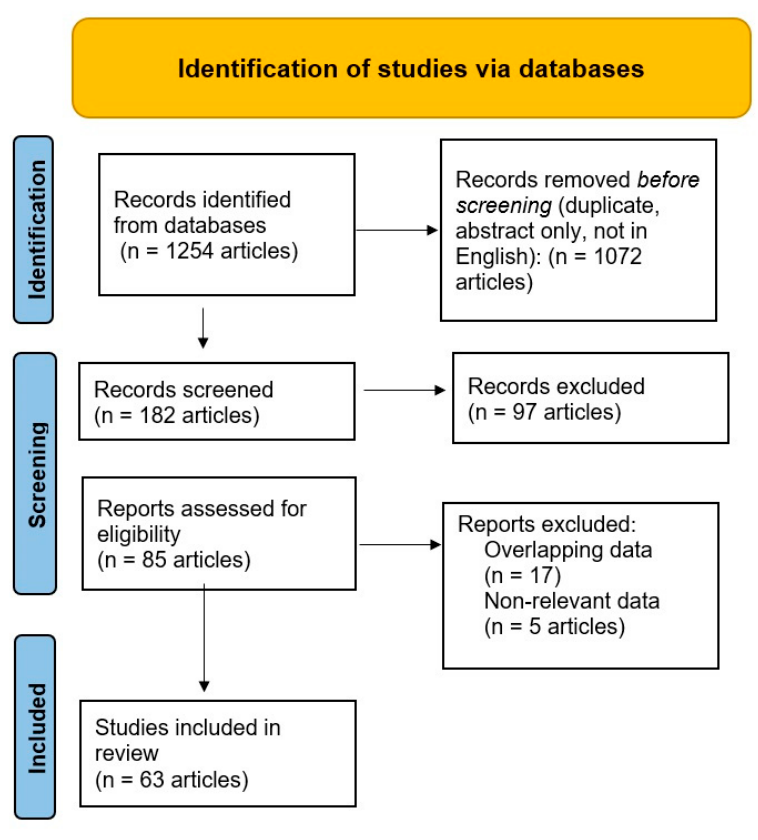
Figure 1. PRISMA flow diagram of the selection of medical articles [23].